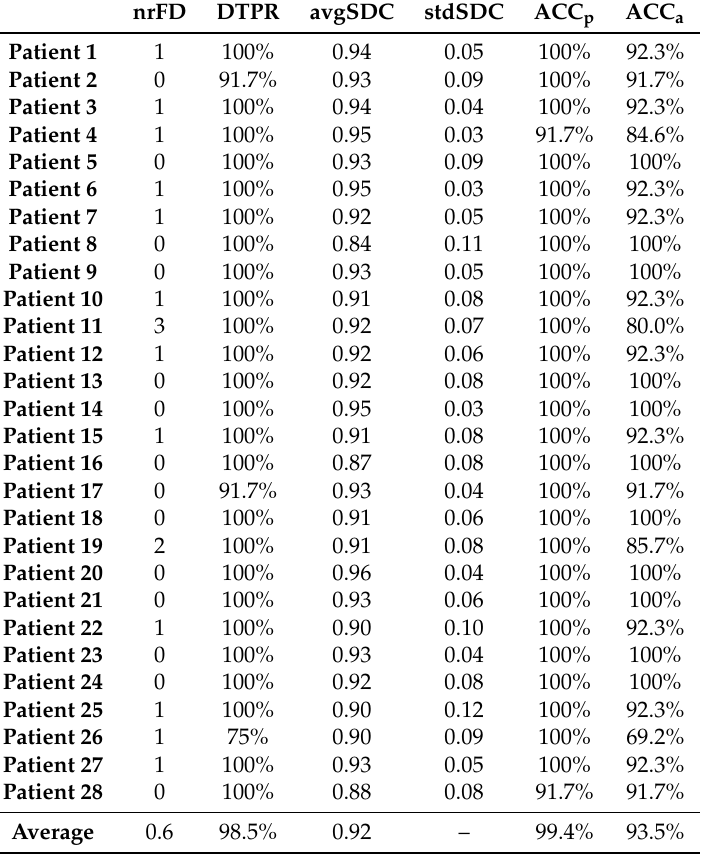
Table 3. Per-patient recognition performance in terms of the number of false detections (nrFD), detection true positive rate (DTPR), average Sørensen–Dice Coefficient (SDC), SDC standard deviation, pure accuracy and actual accuracy. ACC, accuracy.